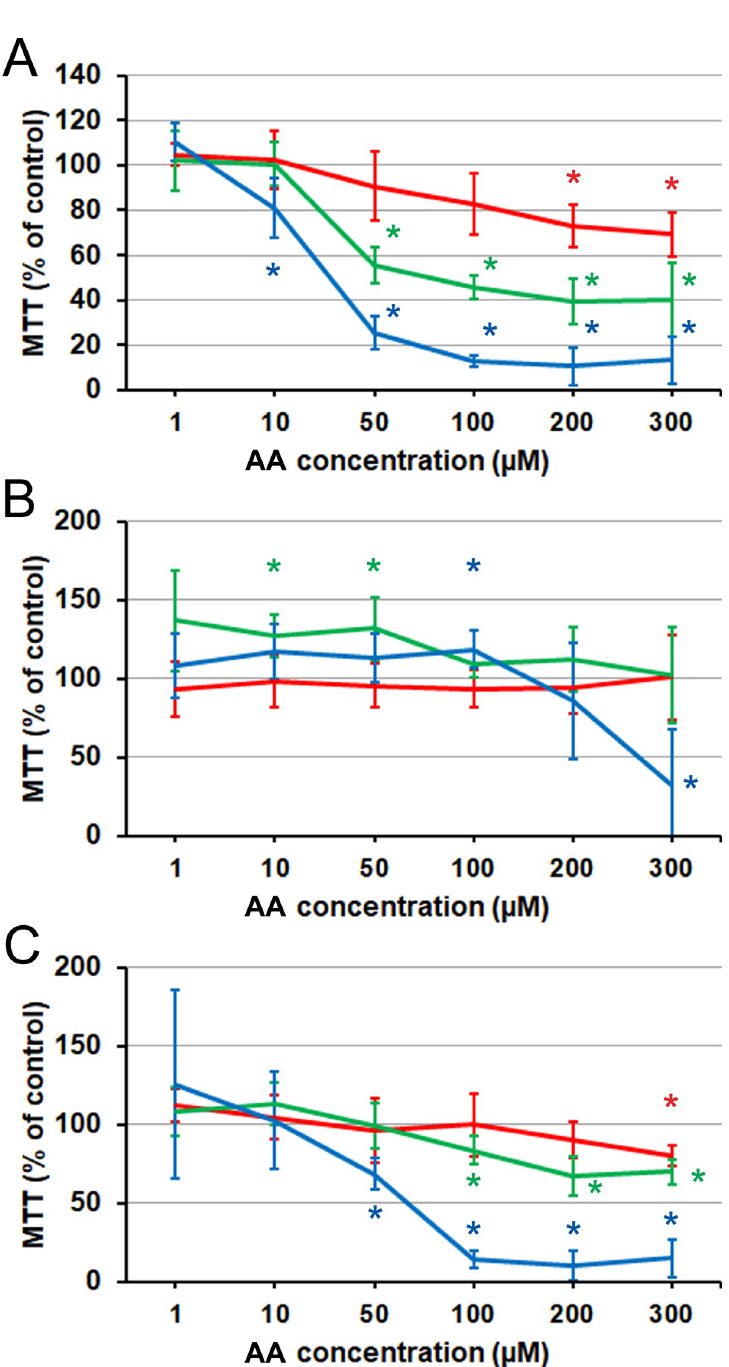
Fig 1. Effect of AA on prostate cancer cells proliferation and viability as measured by MTT assay, relative to the BSA carrier control. (A) PC3 cell line. (B) LNCaP cell line. (C) C4-2 cell line. Red line: 24 h. Green line: 48 h. Blue line: 72 h. Error bars: standard deviation. Asterisks denote statistical significance of the difference from the control on the significance level 0.05, corrected for multiple comparisons (see Methods). 24 h data: each point is the average of n = 6 cell cultures. 48 and 72 h data: each point is the average of n = 9 cell cultures.